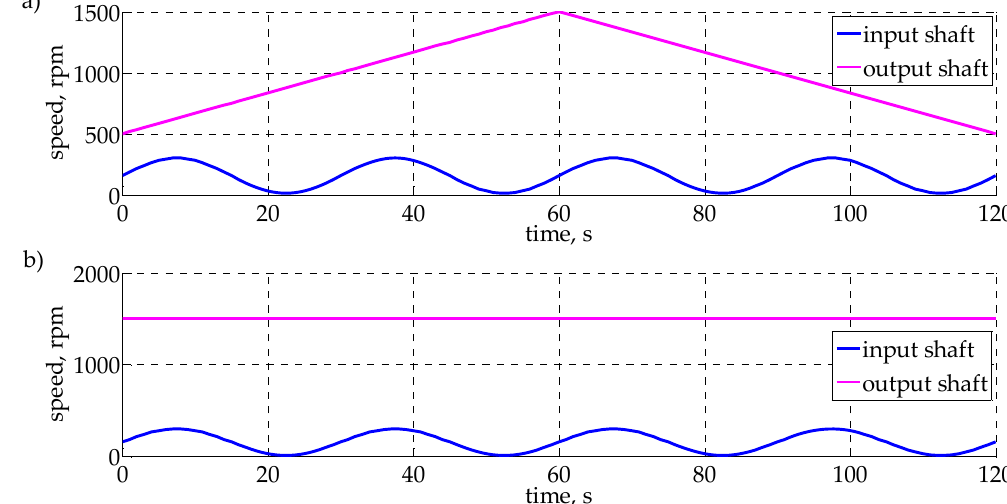
Figure 6. Speed histories of the sample transmission shafts: ( a ) for a linear change of output speed; and ( b ) for a constant output speed.